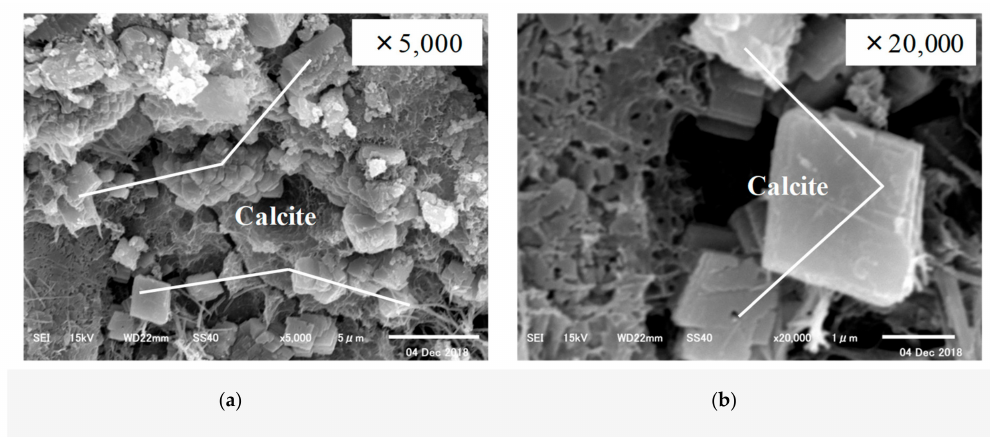
Figure 11. Self-healed substances at 20 ◦ C (CE specimen of IV series) ( a ) 5000x; ( b ) 20,000x.